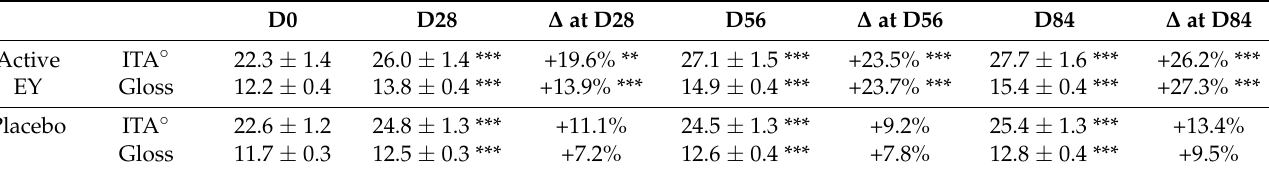
Table 3. Effects on radiance and dark spots colour.